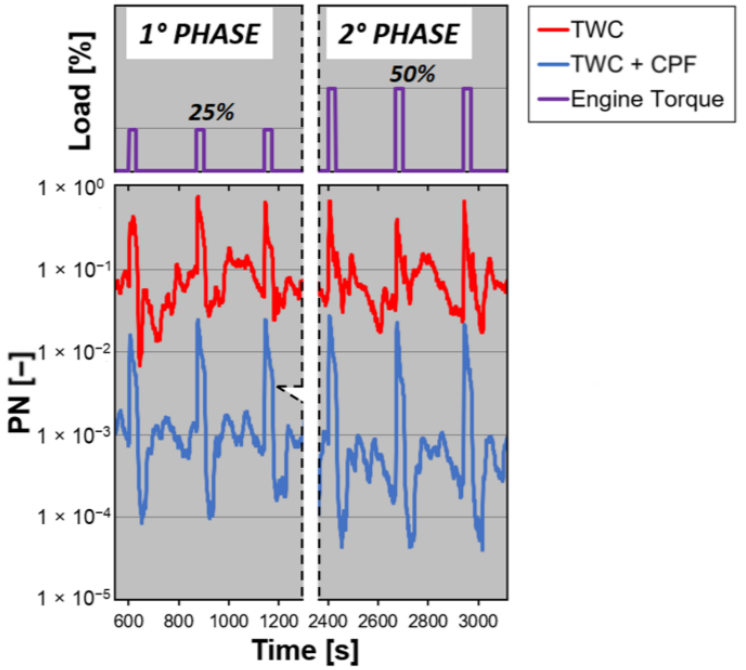
Figure 10. Zoom of the typical PN emission profiles recorded during the step loads campaign at different phases.